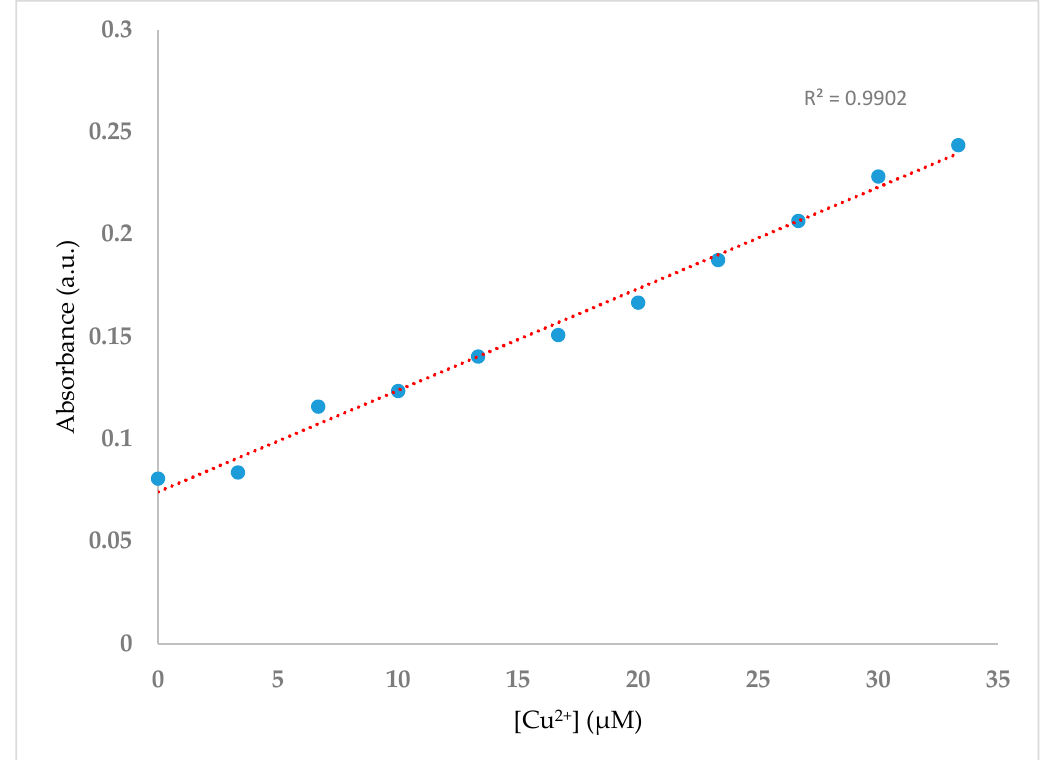
Figure 6. UV ‐ Vis titration spectra of H 2 SB (100 μ M) in methanol ‐ water mixture (80:20 v/v) at room Figure 6. UV-Vis titration spectra of H 2 SB (100 µ M) in methanol-water mixture (80:20 v / v) at room temperature and neutral pH, upon sequential addition of Cu 2+ (0–1 equiv). temperature and neutral pH, upon sequential addition of Cu 2 + (0–1